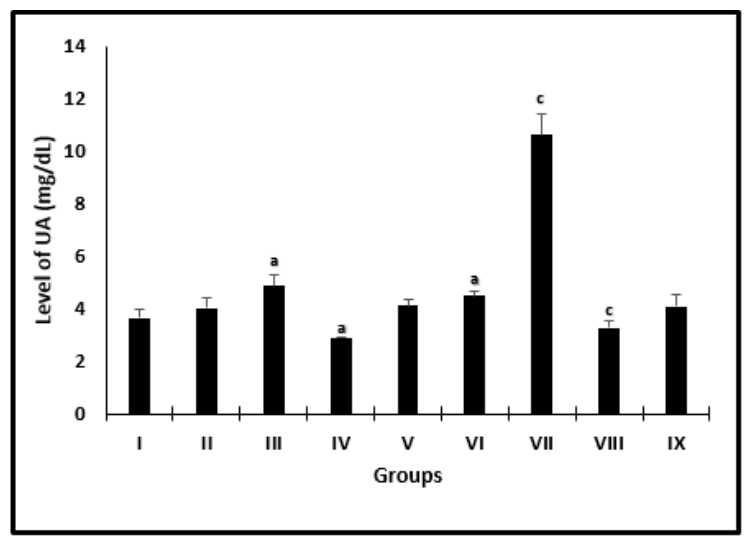
Groups I, II, III, IV, and VI presented saline, PB, PZQ, AL and CU uninfected treated-mice, groups VI, VII, VIII and IX presented infected-untreated, PZQ, AL and CU treated mice.